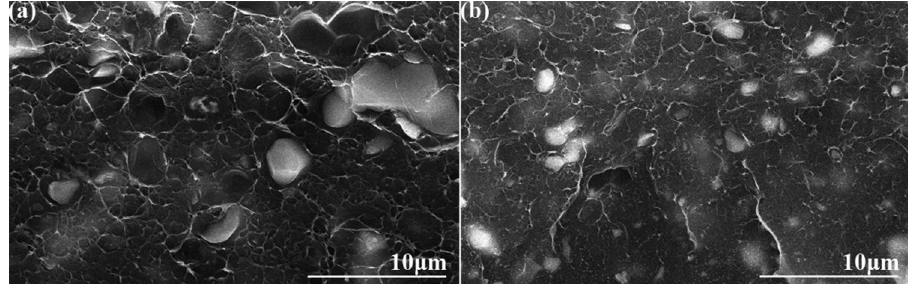
Figure 2: SEM morphologies of ( a ) the 10 vol% CCTO/LDPE composite and ( b ) the 10 vol% CCTZO/LDPE composite.